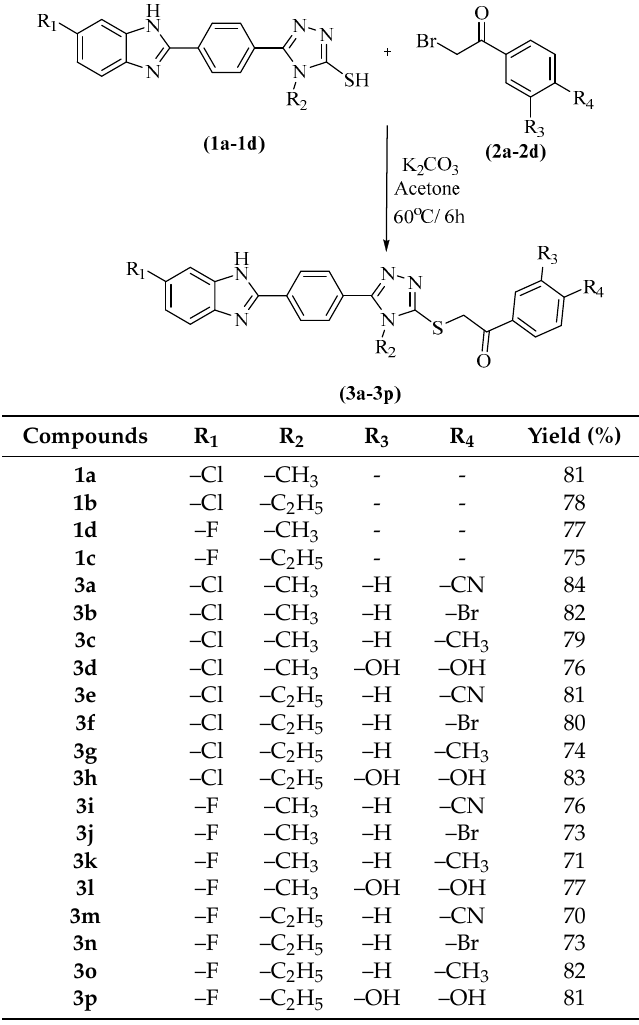
Table 1. % Inhibition of all compounds 5a – p against AChE and BChE